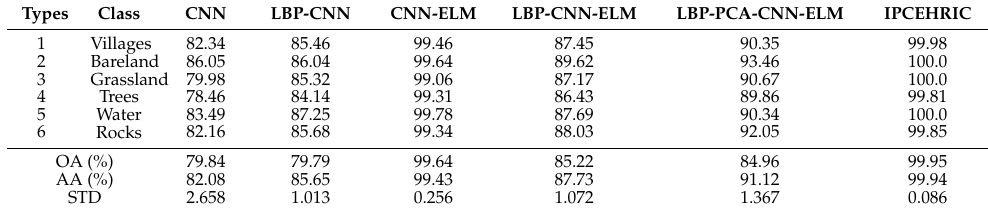
Table 9. The classification results of HRSIs for six types